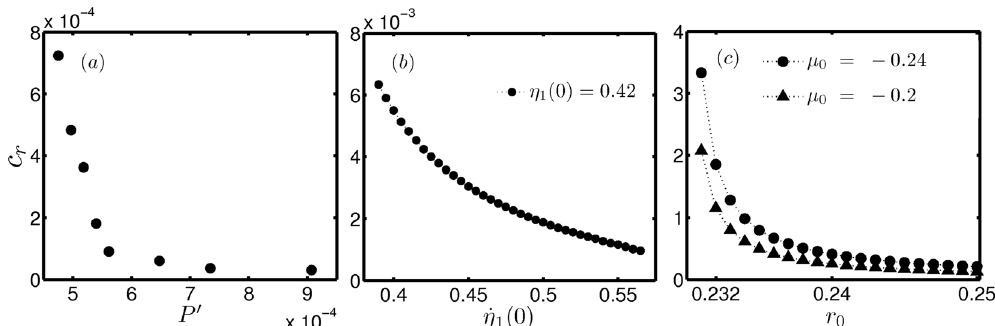
Figure 4. Critical rate required for preconditioned rate induced tipping in ( a ) experiments ( b ) theoretical model and ( c ) normal form equation of subcritical Hopf bifurcation. In ( a ) experiments, we provide an initial periodic perturbation of amplitude P ′ (below the unstable limit cycle) and vary the parameter from .∼ = − K 0 135 to − 0.07. We find the minimum rate ( c r ) at which the tipping occurs for each initial condition. In (b) theoretical model, the parameter is varied from = − .  k 0 145 to = − .  k 0 064 following α = + −   k k t t ( ) , 0 e 0 0 where t 0 = 50, for a set of initial conditions to obtain the critical rate. We set η 1 (0) = 0.42 and varied η  (0) in the 1 model. In ( c ) the normal form ( µ = + −  r r ar br 3 5 , a = 1, b = 1), the parameter μ is varied from μ 0 to a final value μ e = − 0.05. We observe that the critical rate decreases with an increase in μ 0 for the same initial condition. The procedure followed to obtain the critical rates in experiments and model is detailed in